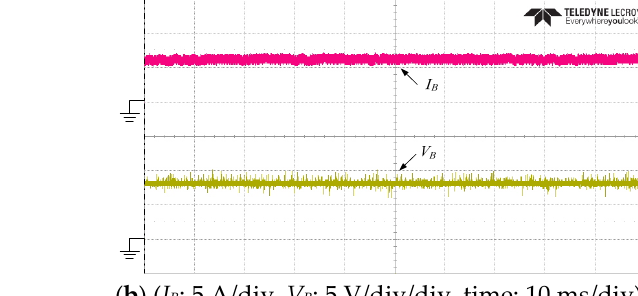
Figure 21. Measured switch voltage V DS and current I DS of the proposed hybrid converter operated in the utility line condition under 100% of the full-load condition: ( a ) switch M 1 and ( b ) switch M 2 .